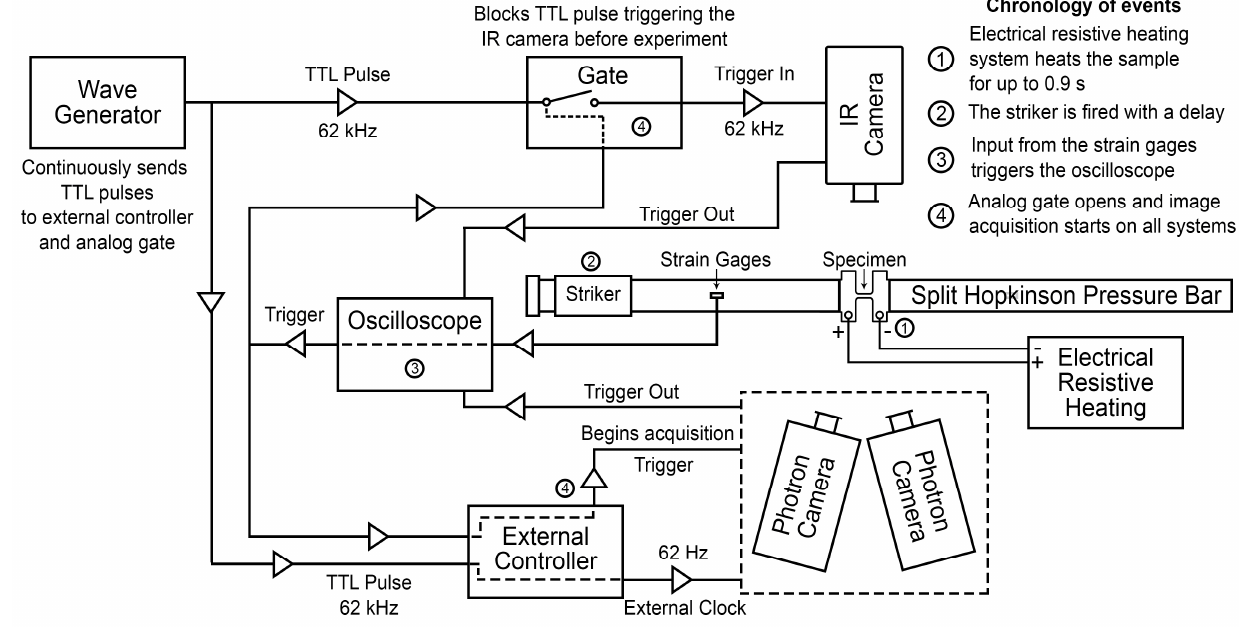
Figure 7. Schematic picture of the testing setup comprising the electrical resistive electric heating system, high-speed cameras, the SHPB tensile bar, the wave generator, the external camera controller, and the path of signals used to synchronously acquire data during the test. The sequence of the events is described in the upper-right corner of the figure and marked with the respective numbers on the picture.